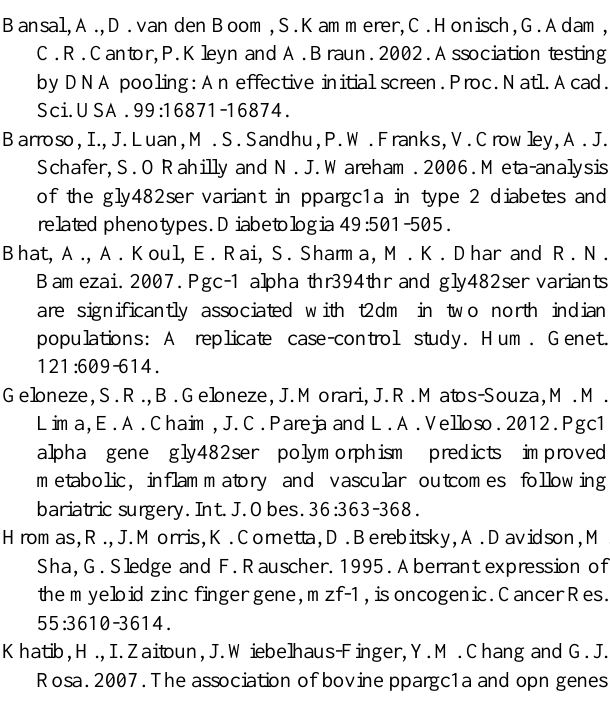
Polymorphisms in promoter region numbered relative to the translation start site; Adenine of the start codon ATG is counted as  1 (GenBank